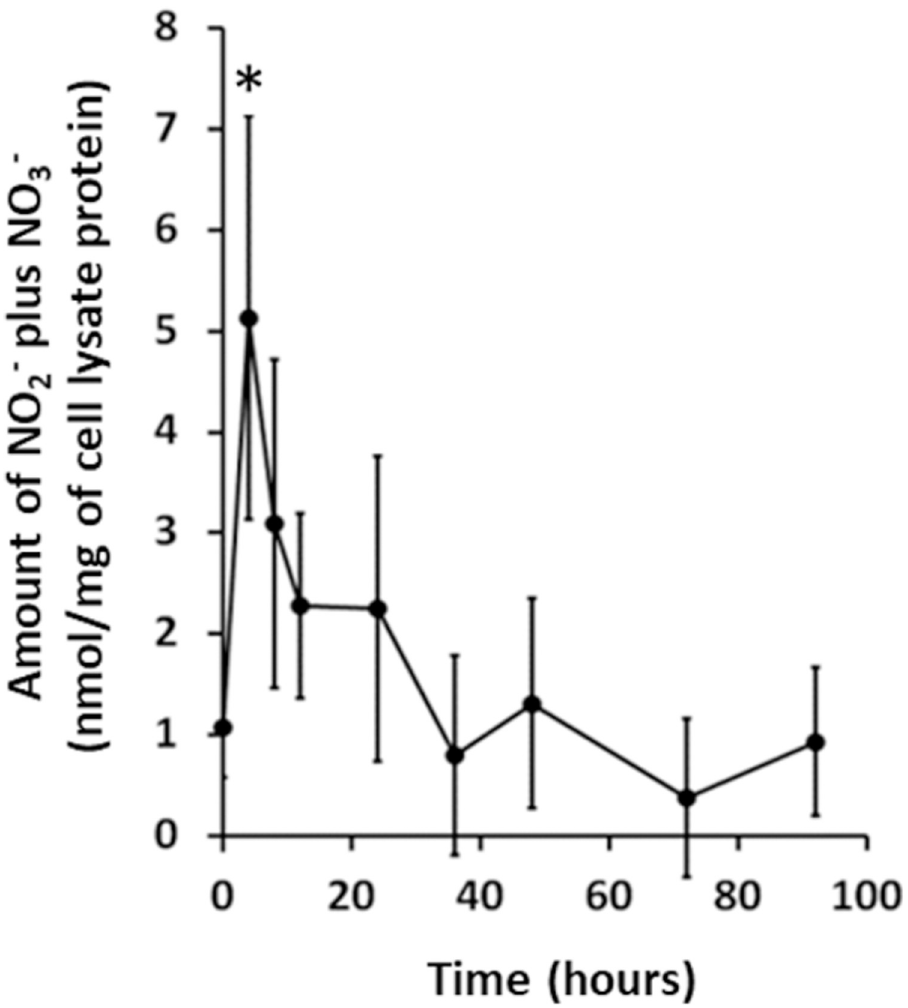
Fig 6. Nitric Oxide levels inferred from nitrate plus nitrite levels in neutrophil lysates. IFN- γ was administered to healthy volunteers just after blood was taken for the time 0 time point and cell lysates were prepared from isolated neutrophils at the indicated times. Nitrate plus nitrite levels were measured by a colorimetric assay. The data is presented as mean ± SEM for n � 6 samples. The asterisk indicates significant difference (p = 0.040) from time 0 (two- tailed